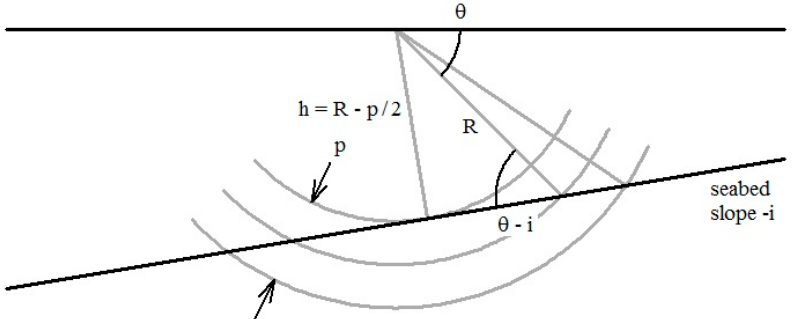
Figure 2. This occurs at the transition between (cid:1856) (cid:2869) being zero and non-zero.